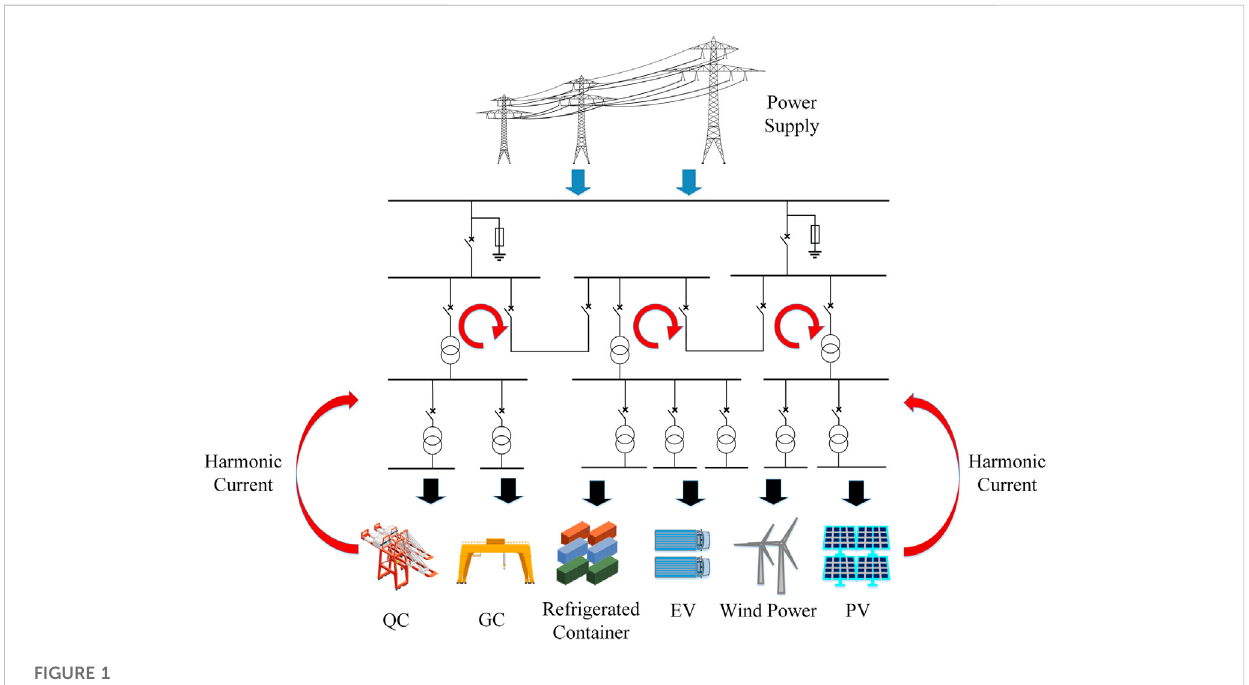
FIGURE 1 Port distribution network